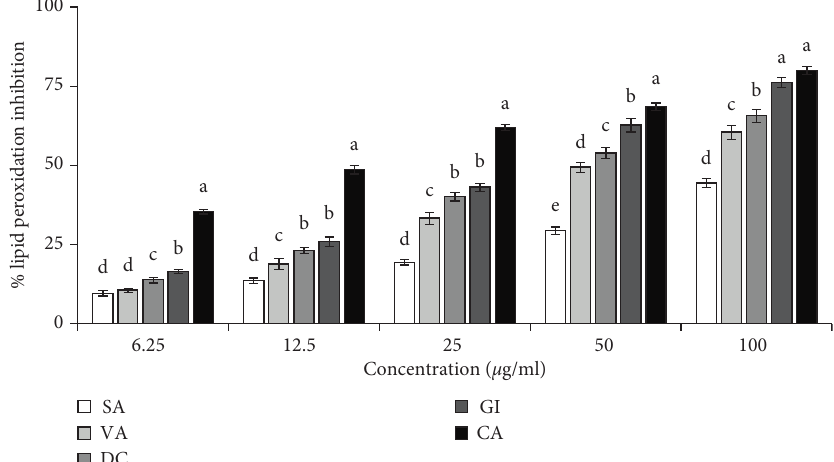
Figure 5: Inhibition of lipid peroxidation by compounds (SA, VA, DC, and GI). IC 50 ( μ g/ml): SA, 141.60 ± 6.19; VA, 57.02 ± 2.78; DC, 44.20 ± 1.01; GI, 32.28 ± 1.10; CA, 14.10 ± 0.43. Catechin (CA) was used as a reference antioxidant. Results represent mean ± SD ( n � 3). Compound 1 had no activity and was not shown. Means with different letters (a–e) differ significantly ( P < 0 . 05). SA, syringaldehyde; VA, vanillin; DC, dihydroconiferyl dihydro- p -coumarate; GI, gigantol; CA,